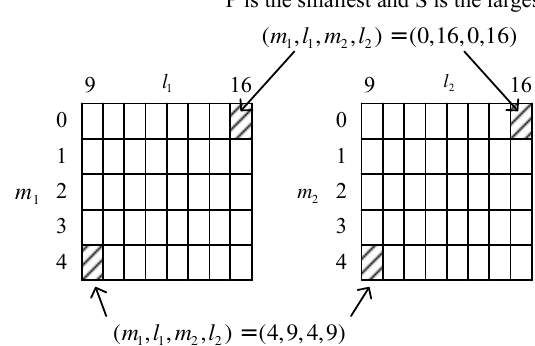
Figure 1. P (estimation error covariance) and S (transmission rate) relationship according to